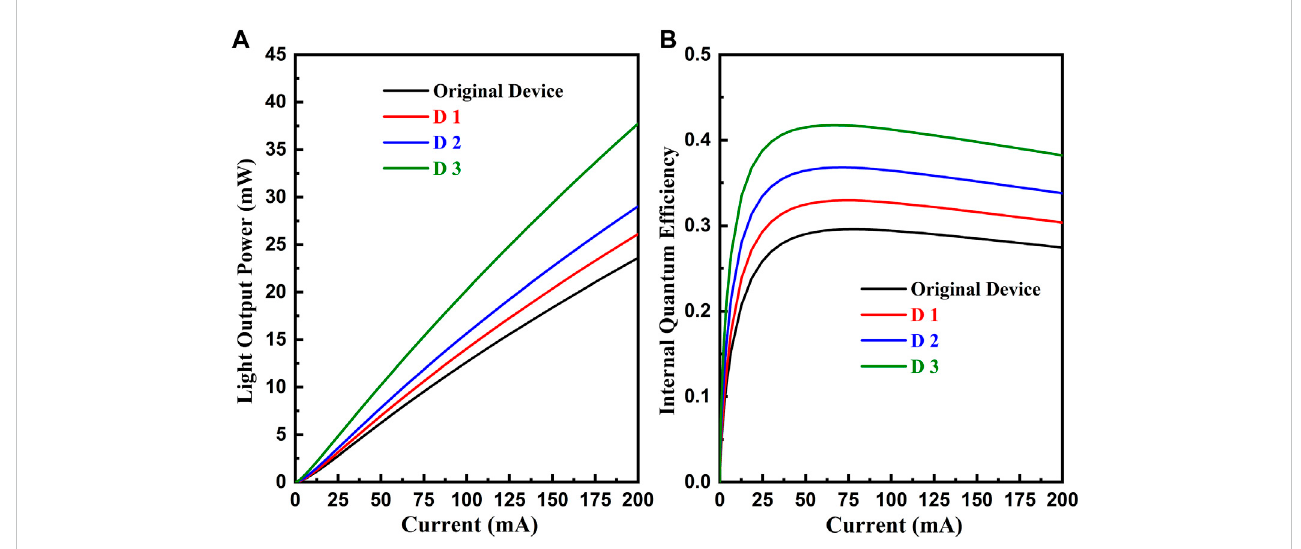
These results suggest that D3 achieved the highest IQE and LOP due to the introduction of a proper EDL. Figure 3 depicts the energy band diagrams of four LEDs to exhibit the origin of enhanced optoelectronic performance. The green region represents the EDL area. Δ E c1 is de fi ned as the